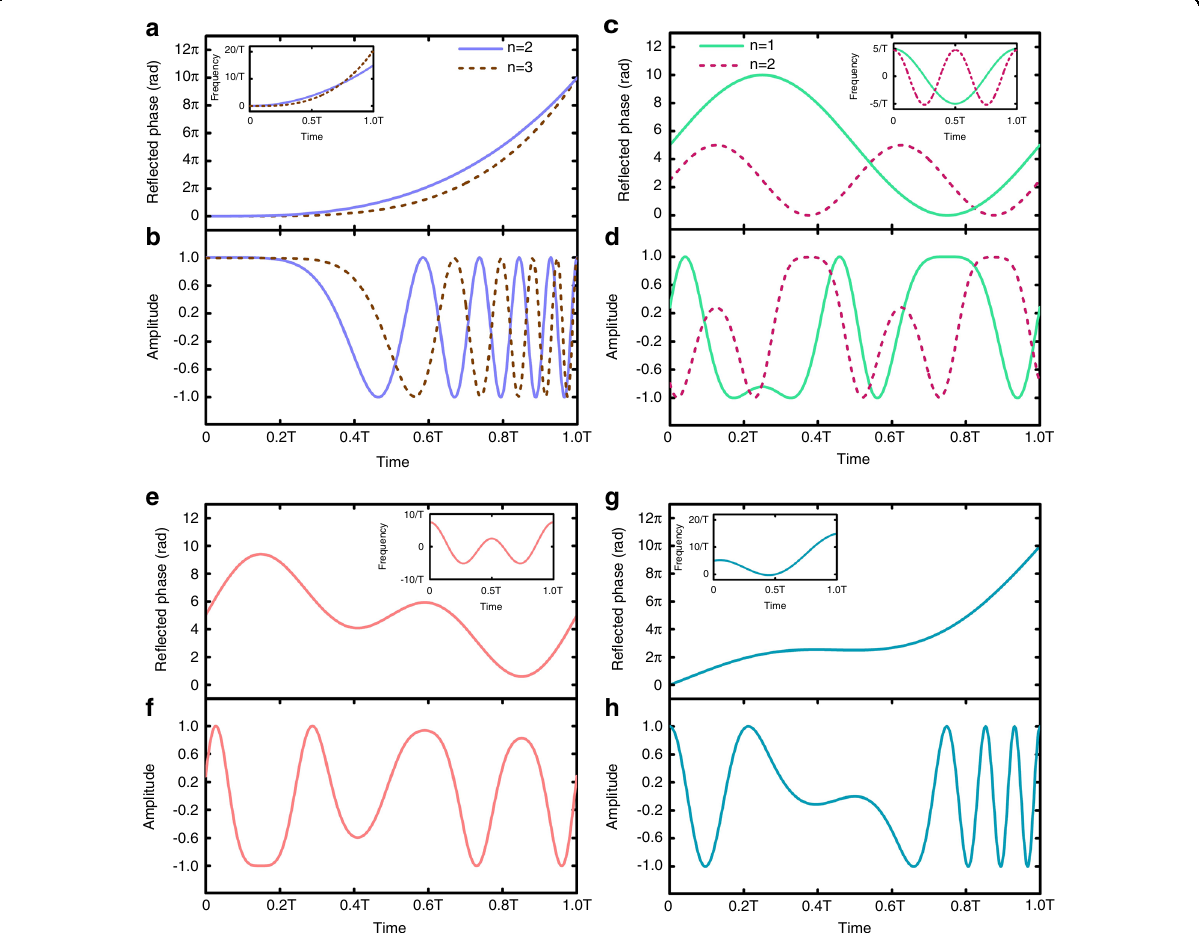
Fig. 3 Generations of nonlinear FMCW signals based on STCM with nonlinear periodic phases. a , c , e , g, Re fl ection phase responses φ 0 t ð Þ for Polynomial FMCWs under two different power index n ( a ), Sinusoidal FMCWs under two different coef fi cient n ( c ), Double sinusoidal FMCW ( e ), and S-shaped FMCW ( g ), in which the insets of a , c , e , g show the corresponding time-frequency diagrams after down-conversions. b , d , f , h The nonlinear FMCW waveforms of the four types in